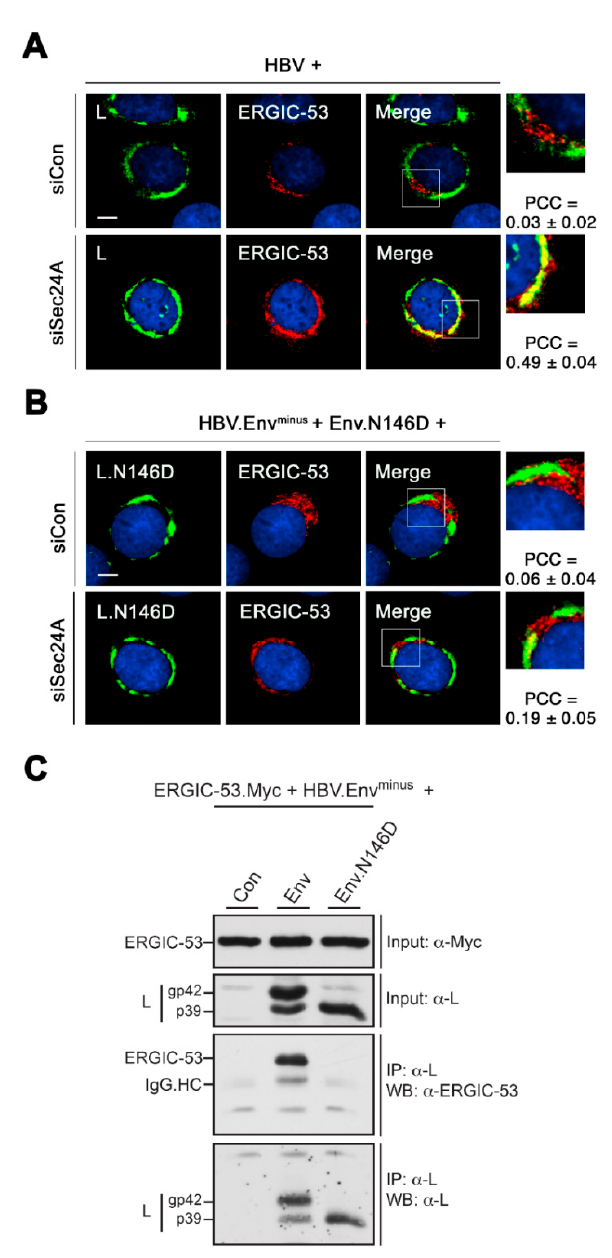
Figure 7. HBV L colocalizes and interacts with ERGIC-53 in a N146-glycan-dependent manner. ( A , B ) IF analyses of HuH-7 cells treated with control or siSec24A-specific duplexes for two days followed by transfection with the wt HBV replicon ( A ) or glycan-defective HBV replicon ( B ) for an additional 2 days. PFA-fixed cells were stained with anti-L (K1350, L, green) and anti-ERGIC53 (red) antibodies. Merged images are shown in the right panels, with outlined areas shown at larger magnification. For QCA, PCC values were calculated and represent the mean ± SD. Bar, 10 µ M. ( C ) For CO-IP analysis, HuH-7 cells were cotransfected with a Myc-tagged version of ERGIC-53 (ERGIC-53.Myc) and HBV.Env minus complemented with either the wt (Env) or mutant Env.N146D constructs. To test for equal input amounts, cell extracts prepared by Triton lysis were probed by WB with anti-Myc and anti-L (K1350) antibodies. Lysates were precipitated with mouse anti-L (57761) antibodies and analyzed by WB using rabbit anti-ERGIC-53 (E1031) antibodies. To confirm equal IP e ffi ciencies, the same blot was reprobed with anti-L